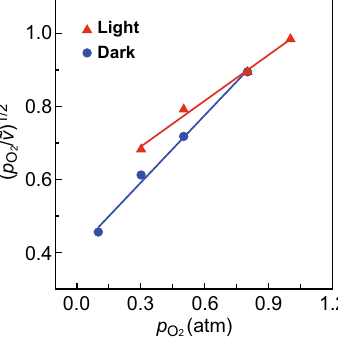
Fig. 4 Dependence of reaction rate with a partial pressure of O 2 ( p O 2 ) in the atmosphere, tested under photo-illumination of an effec- tive light power of 520 mW (red dots) and dark condition (blue dots). The results are plotted according to the linear form of the Langmuir– Hinshelwood model in which oxygen molecules are associatively adsorbed on the catalyst surface. ̃𝜈 represents the reaction rates nor- malized against the corresponding reaction rate under 0.8 atm. (Color figure